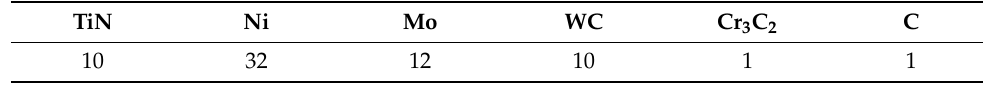
Table 1. The composition of M